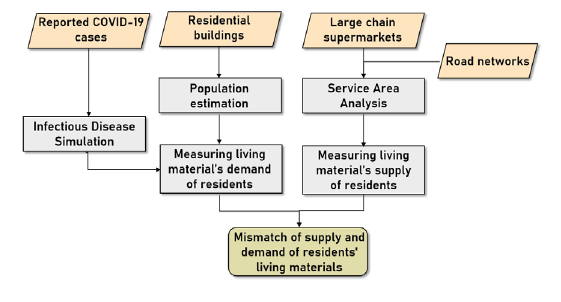
Figure 1. The workflow of the presented framework